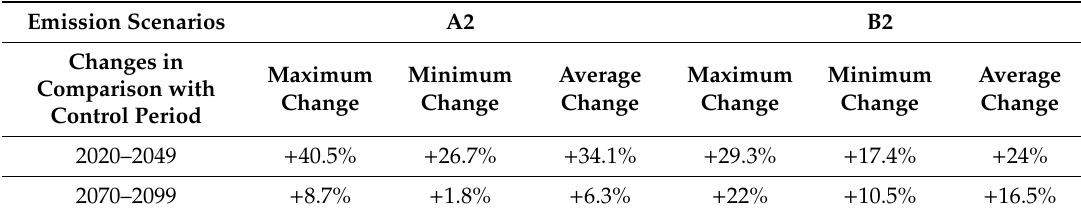
Figure 12. Changes of the annual hydropower in the near and far future under A2 and B2 scenarios compared with the observed periods. Table 6. Predicted changes of mean annual simulated hydropower energy in the near and far future in comparison with the 1971–2000 period.